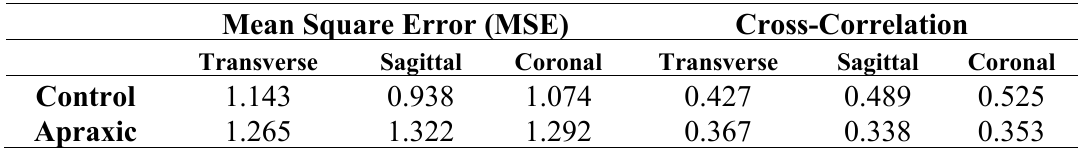
Table 4. Mean Square Error (MSE) and cross-correlation values for the transverse, sagittal, and coronal axes.